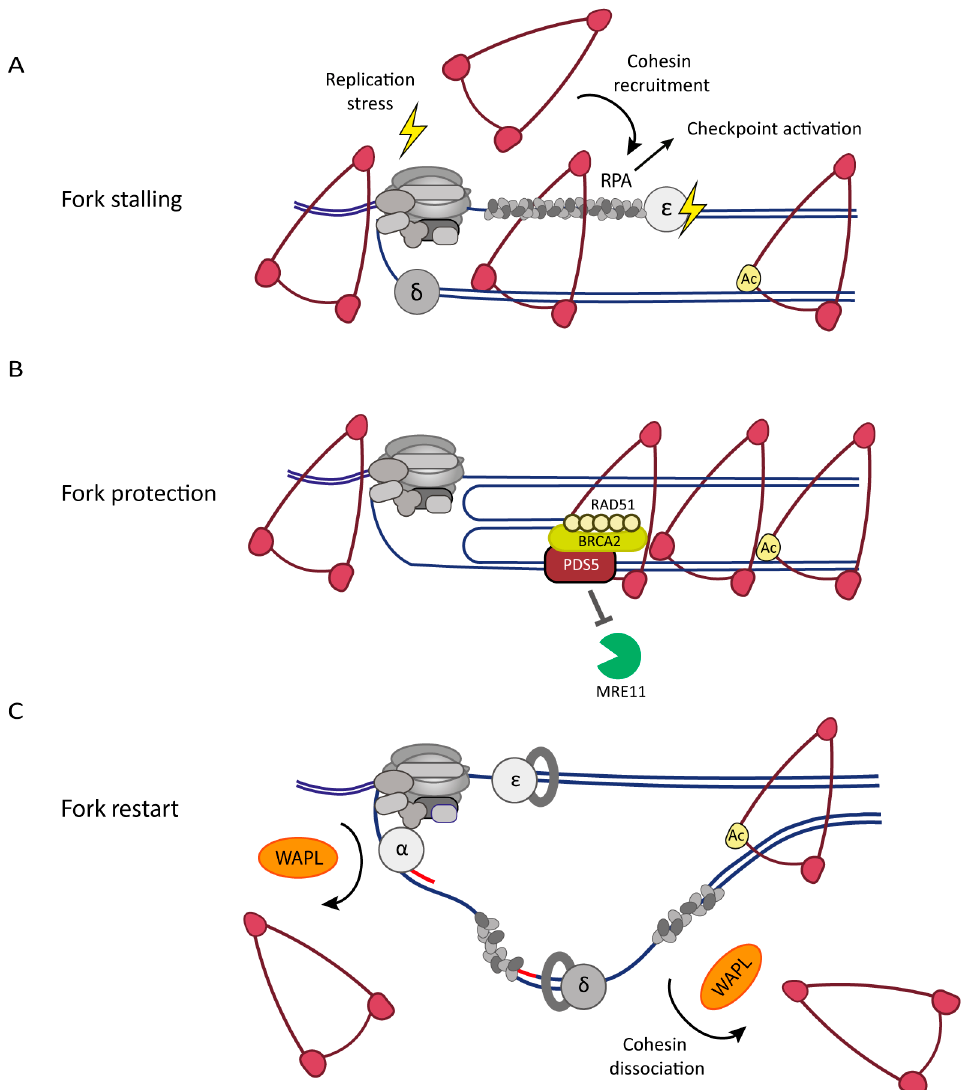
Figure 3. Cohesin dynamics in the DNA replication stress response: ( A ) Replication fork stalling can cause uncoupling of the polymerase from CMG, resulting in stretches of RPA-coated ssDNA that activate the replication checkpoint and are thought to promote cohesin recruitment. ( B ) The stalled fork undergoes extensive remodeling, often involving fork reversal to aid fork restart. Cohesin may be involved in protecting stalled replication forks and in facilitating template switching to repair DNA lesions. PDS5 contributes to the recruitment of BRCA2 and RAD51, which protect reversed forks against excessive nuclease processing. ( C ) Repair and restart depend on WAPL-mediated cohesin mobilization, possibly by increasing cohesin turnover at stalled forks. DNA replication is resumed while cohesin levels are decreased. Not all factors involved are shown in the figure for simplicity; for further details, see text.